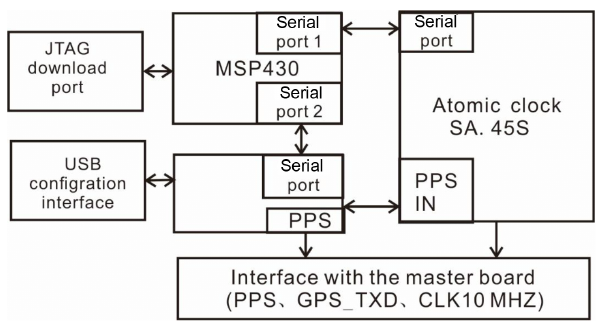
Figure 5. Block diagram of high precision atomic clock